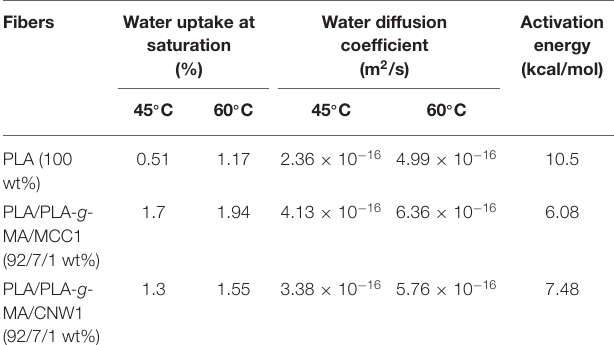
TABLE 1 | Values of water uptake at saturation, water diffusion coefficient and activation energy of PLA, PLA/PLA -g- MA/MCC1, and PLA/PLA -g- MA/CNW1 fibers recorded at 45 and 60 ◦ C in hygrothermal